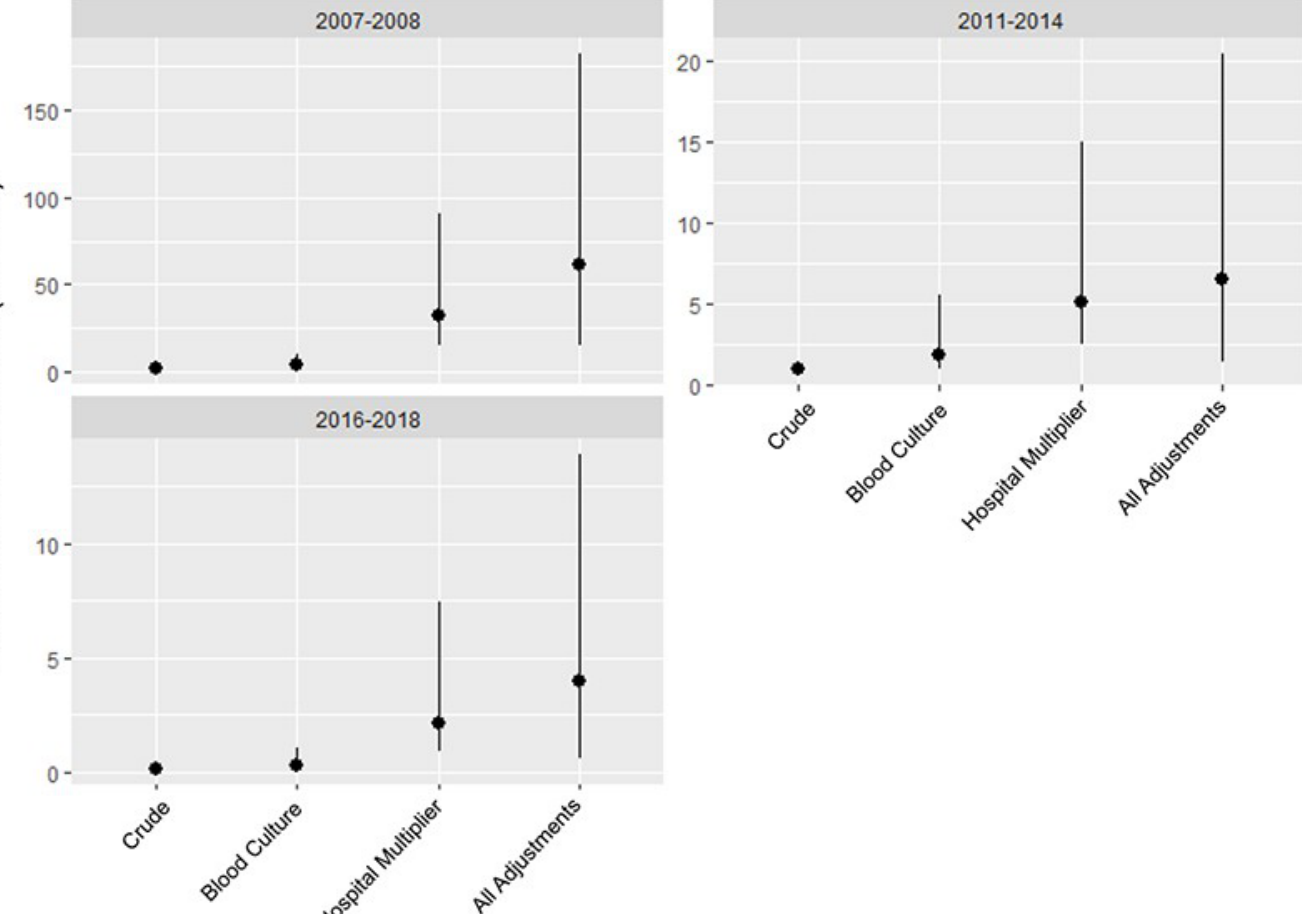
Fig 3. Crude incidence and key adjustments of incidence estimates using hybrid surveillance and Bayesian hierarchical model, Kilimanjaro Region, Tanzania, 2007–2018. The graphs depict the application of the multiplier method and Bayesian estimation model for each study period in order to show the adjustments from an initial crude incidence to the final incidence point estimates (per 100,000 persons) and to show the credible intervals around the point estimates at each stage of adjustment. The crude incidence is first adjusted to account for the imperfect sensitivity of Blood Culture; this adjusted incidence is further adjusted by the hospital multiplier to account for case under-ascertainment by sentinel site surveillance. The far right of each plot’s x-axis, All Adjustments, reflects the full model as described in Methods and Supplementary Methods.